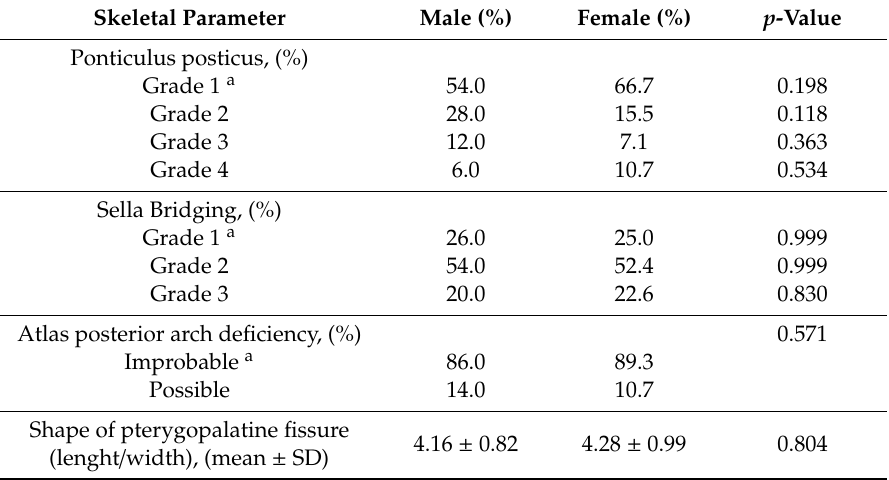
Table 5. Prevalence of skeletal measurements in males and in females. Skeletal Parameter